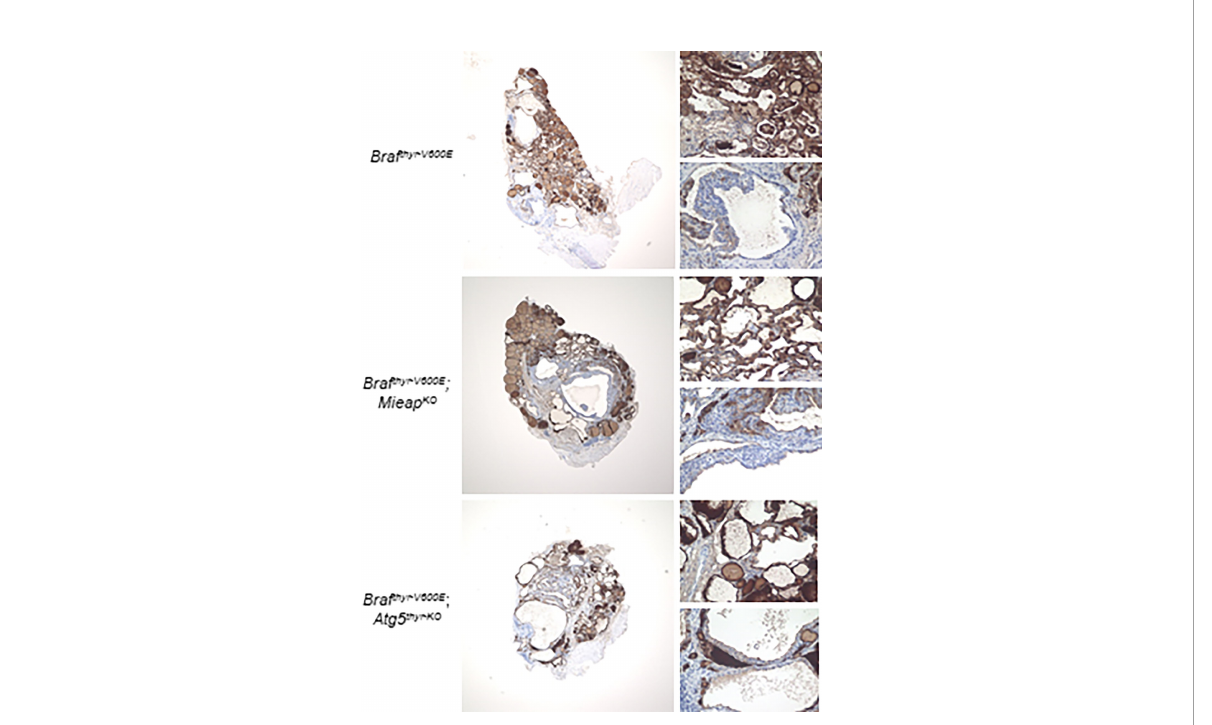
FIGURE 2 Immunohistochemistry (IHC) staining for thyroglobulin (Tg) expression in the Braf thyr – V600E , Braf thyr – V600E ,Mieap KO/KO , and Braf thyr – V600E ,Atg5 thyr – KO/ KO mice at 12 months. The upper – and lower – right panels in each tissue depict normal and defective Tg expression areas, respectively. The thyroid glands obtained in Figure 1 were used for Tg staining as described in Materials and methods . The original magni fi cations were ×40 and